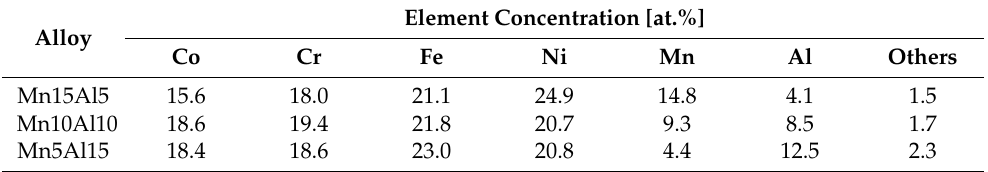
Table 2. Chemical compositions (at.%) of compacted alloys determined by XRF analysis. Alloy